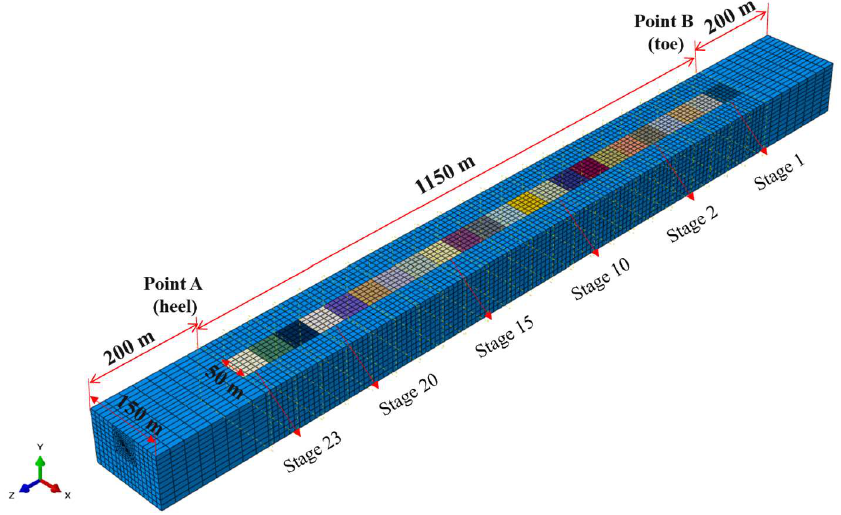
Figure 7. Results of different fracturing zones.